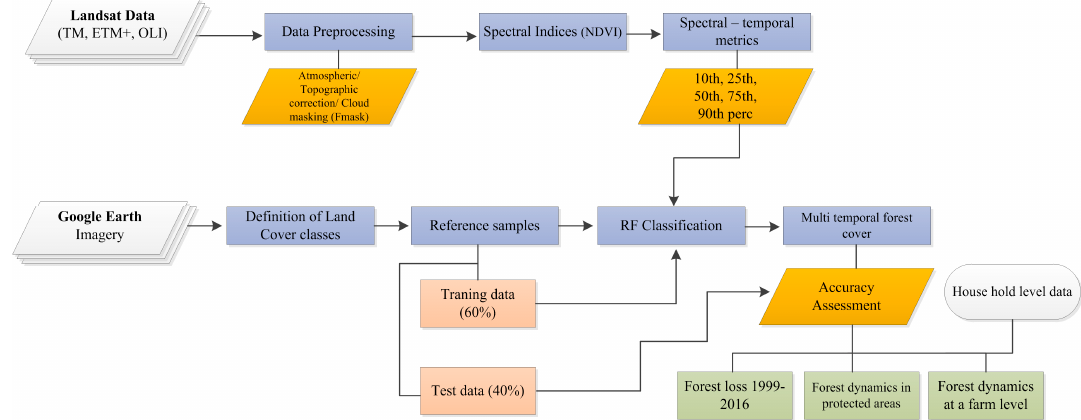
Figure 2. Workflow of remote sensing data processing and classification procedures (source: adapted from Mack et al. [33].